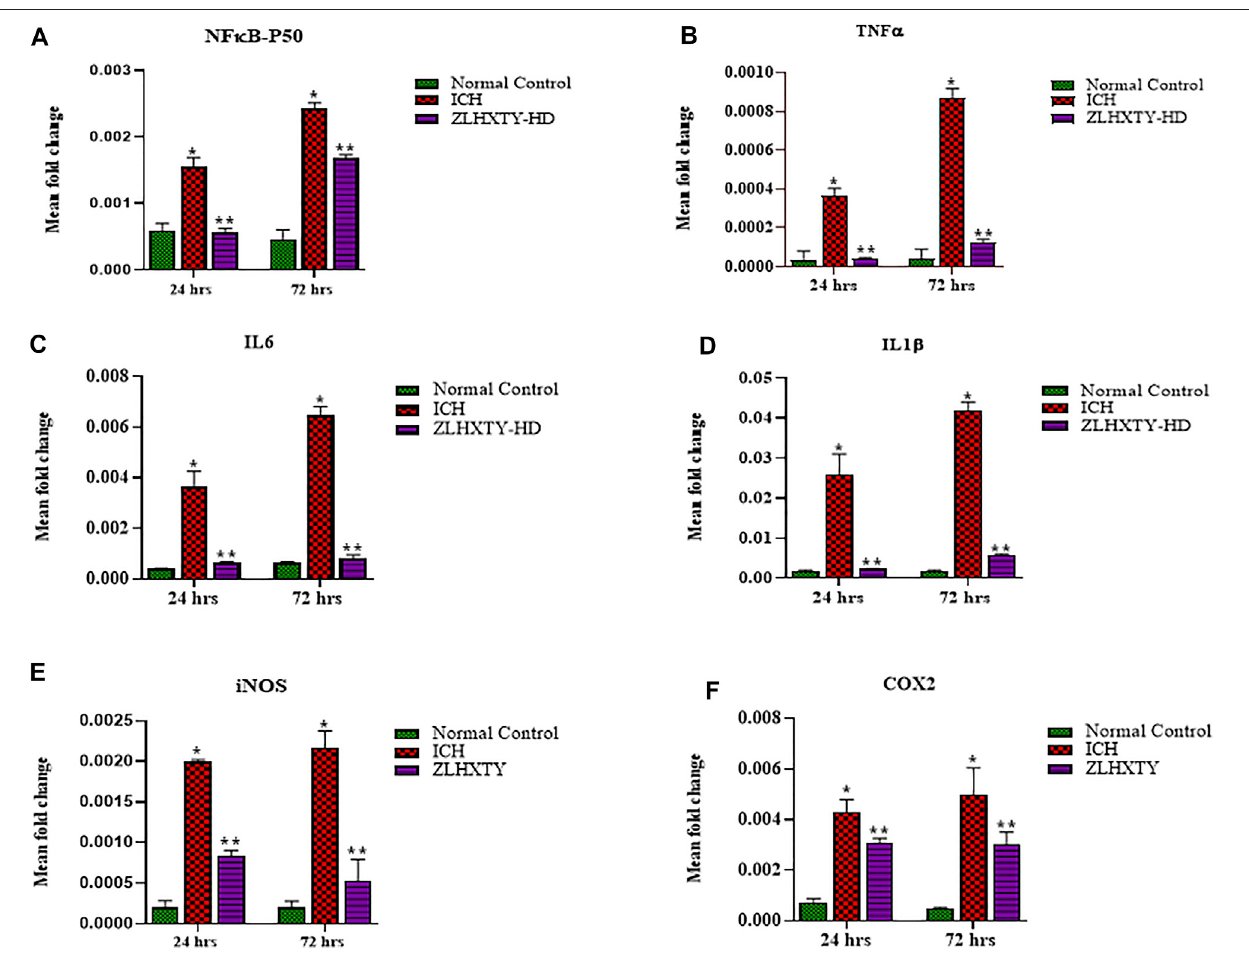
FIGURE 4 | RT-qPCR revealed ZLHXTY treatment reduced mRNA expression of in fl ammatory cytokines. Graphs showing relative expression levels of mRNA (A) NF κ B-P50, (B) TNF α , (C) IL6, (D) IL1 β , (E) iNOS, and (F) COX2; in normal control, ICH and ZLHXTY-HD treatment groups after 24 and 72 h. The mRNA expression of in fl ammatorycytokineswerereducedafterZLHXTY-HDcapsuletreatment for24 hthatbecomesparticularlysigni fi cantafter72 h.Datarepresent themean±SD, n =9, * p < 0.05 as compared to normal control, ** p < 0.05 as compared to ICH group.